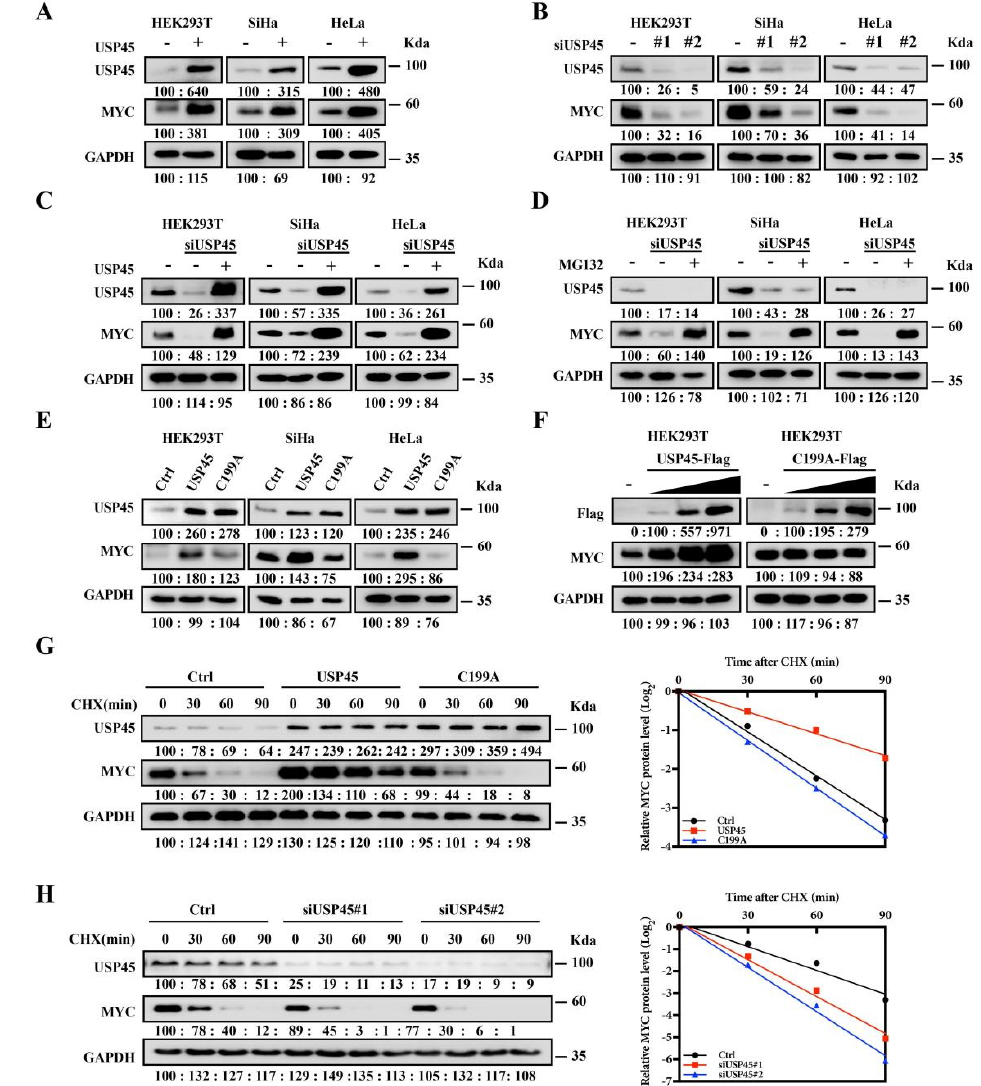
Figure 1. USP45 upregulates MYC protein level and stability. ( A ) Overexpression of USP45 upregu- lated MYC levels. Cells transfected with USP45 were assayed by Western Blot, plvx-puro vector as the negative control. ( B ) Knocking down USP45 with siRNA reduced the MYC levels. Cells transfected with USP45 siRNA were assayed by Western Blot, GFP siRNA as the negative control. ( C , D ) The decreases of MYC with USP45 siRNA were reversed by overexpression of USP45 or addition of a proteasome inhibitor (MG132): ( C ) USP45-expressing plasmid was introduced into cells together with USP45 siRNA, followed by MYC level measurement with Western Blot, plvx-puro and GFP siRNA as the negative control; ( D ) Cells transfected with USP45 siRNA were treated with or without MG132 (20 µM, 12 h), followed by MYC level measurement with Western Blot, GFP siRNA as the negative control. ( E ) USP45 overexpression enhanced MYC level, while its C199A mutant did not. Cells transfected with the control or USP45 (WT or the C199A mutant) were assayed by Western Blot, plvx-puro vector as the negative control. ( F ) USP45 overexpression resulted in MYC elevation in a dose-dependent manner, while its C199A mutant did not. USP45 or C199A with the increased amounts were transfected into cells, and MYC levels were detected, plvx-puro vector as the negative control. ( G , H ) USP45 enhanced the stability of MYC: ( G ) SiHa cells transfected with USP45 and C199A were treated with cycloheximide (CHX, 50 µg/mL), and collected at the indicated times for Western Blot, plvx-puro vector as the negative control; ( H ) SiHa cells transfected with USP45 siRNA were treated with cycloheximide (CHX, 50 µg/mL) and collected at the indicated times for Western Blot, GFP siRNA as the negative control. Experiments were conducted at least two times in dupli- cates.